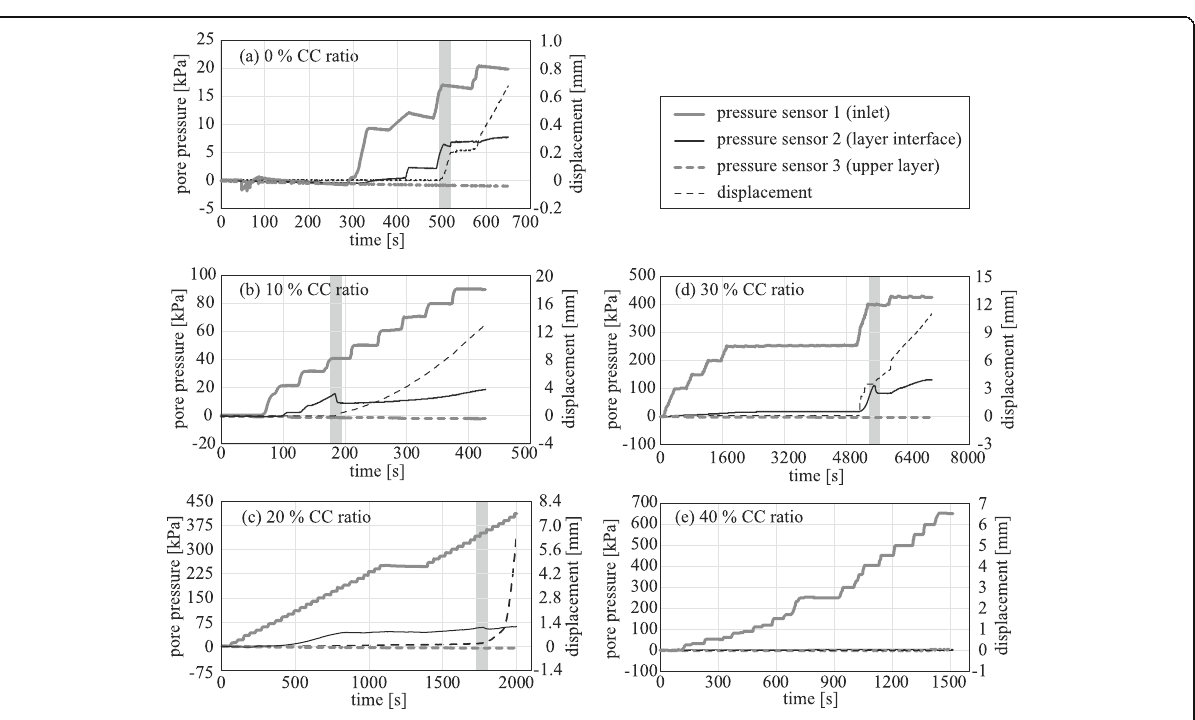
Fig. 8 Responses recorded at different CC ratios: a 0%, b 10%, c 20%, d 30%, and e 40%. The scale varies between specimens. Gray areas indicate periods of water film formation with a notable decrease in pressure sensor 2 and an increase in deformation